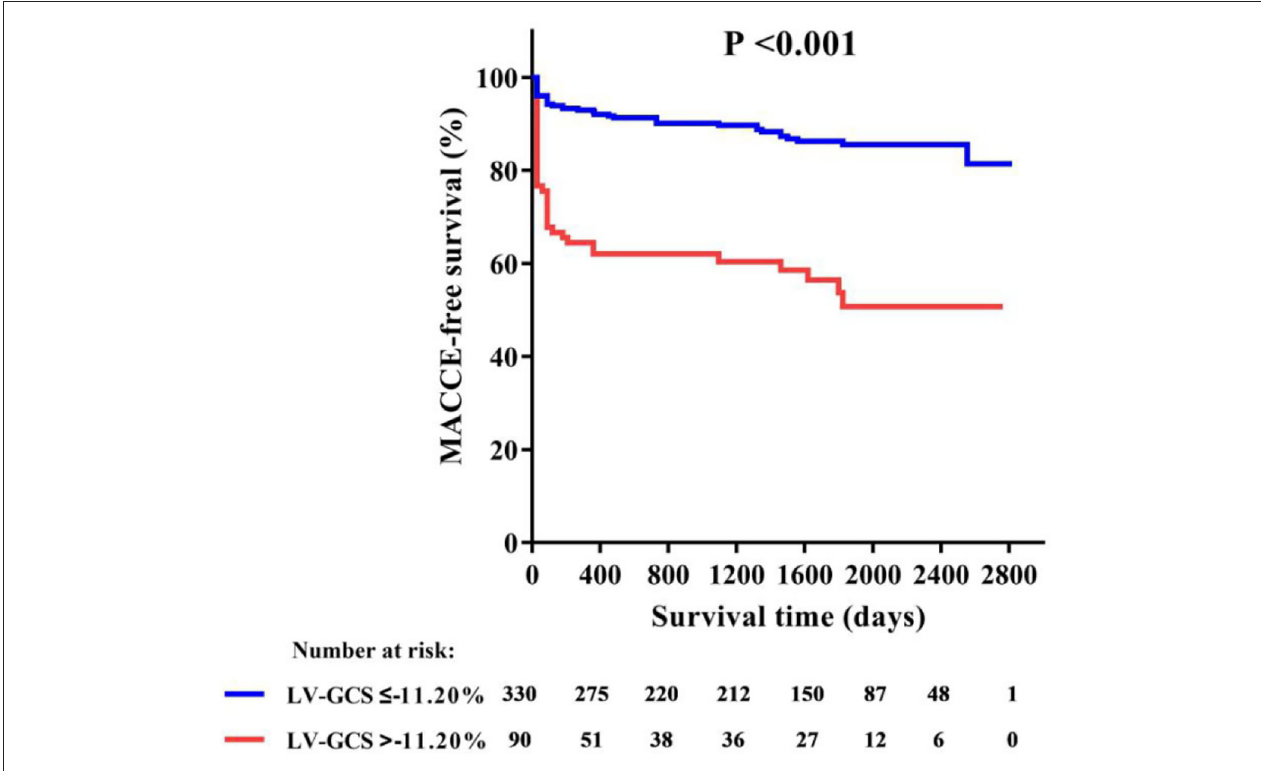
FIGURE 3 | Kaplan-Meier curve of MACCE-free survival in patients with or without LV-GCS impairment. GCS, global circumferential strain; MACCE, major adverse cardiac and cerebrovascular